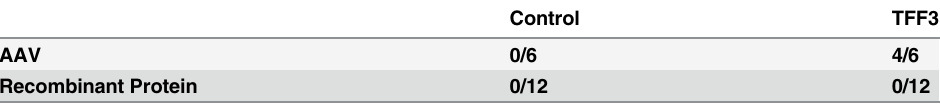
Mice were injected with an AAV vector expressing TFF3 or a control empty vector, or mice were treated with recombinant TFF3 protein or a vehicle control. The entire stomach was collected, cut longitudinally, laid fl at on a piece of cardboard then embedded for histological analysis of the entire length of the